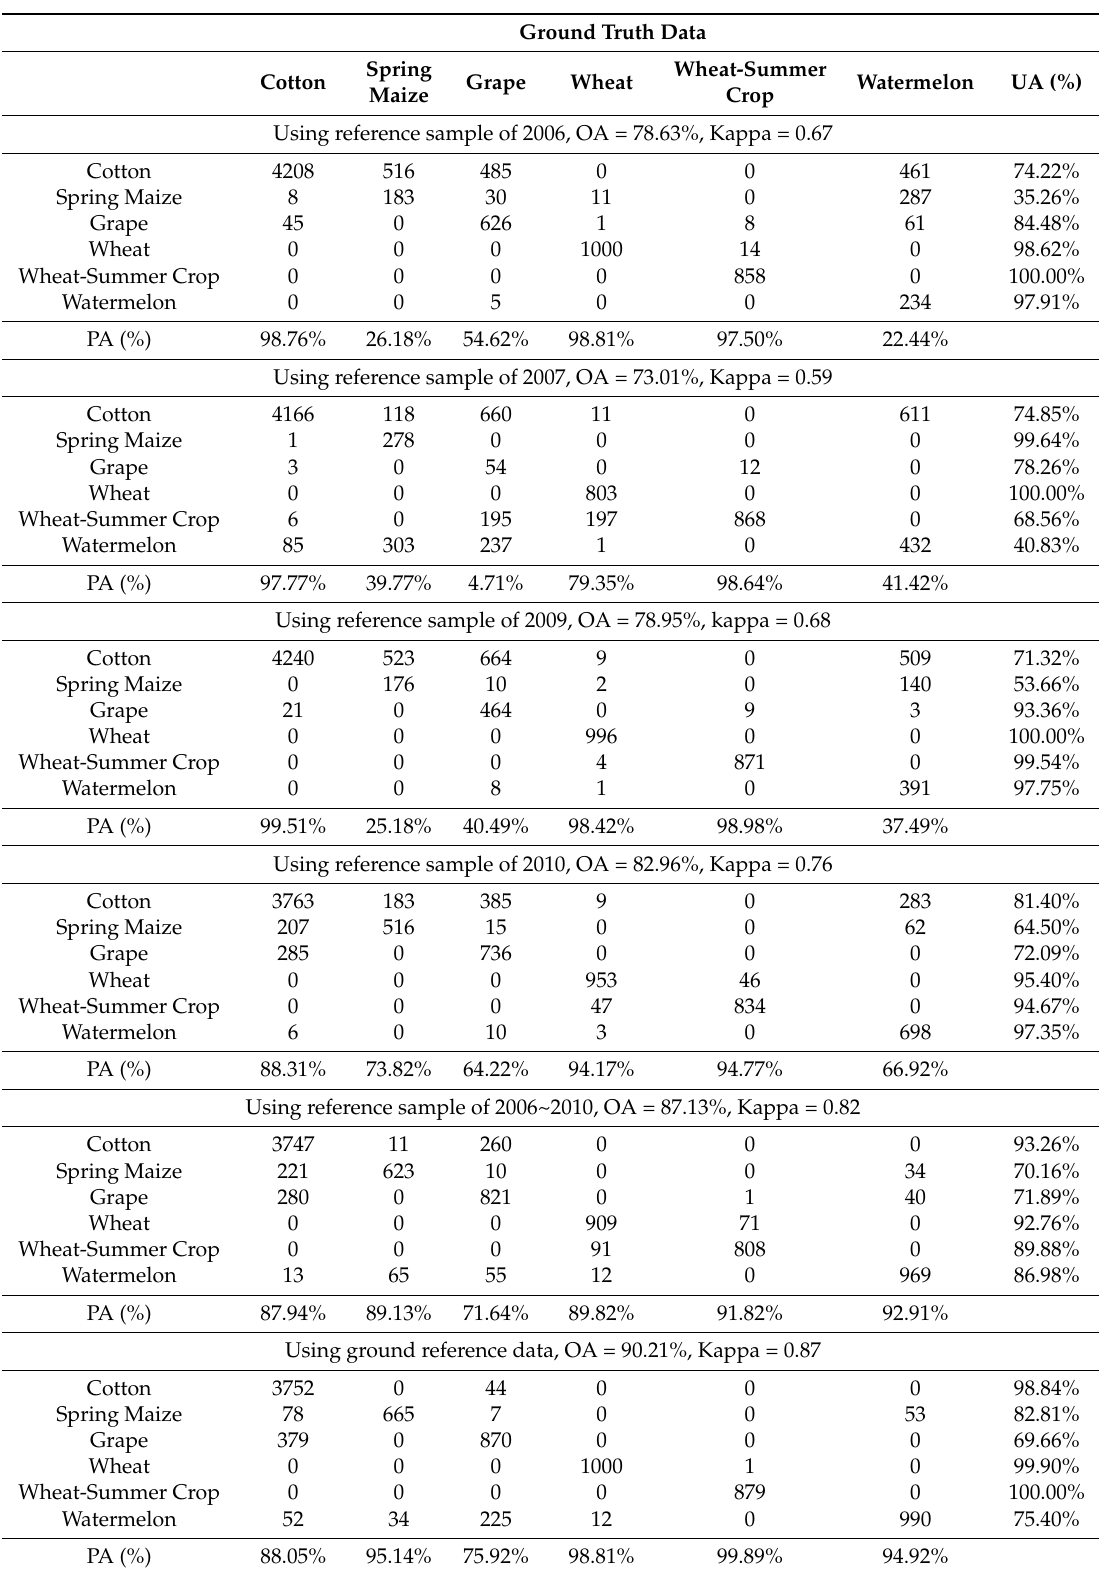
Table 8. Error matrix for